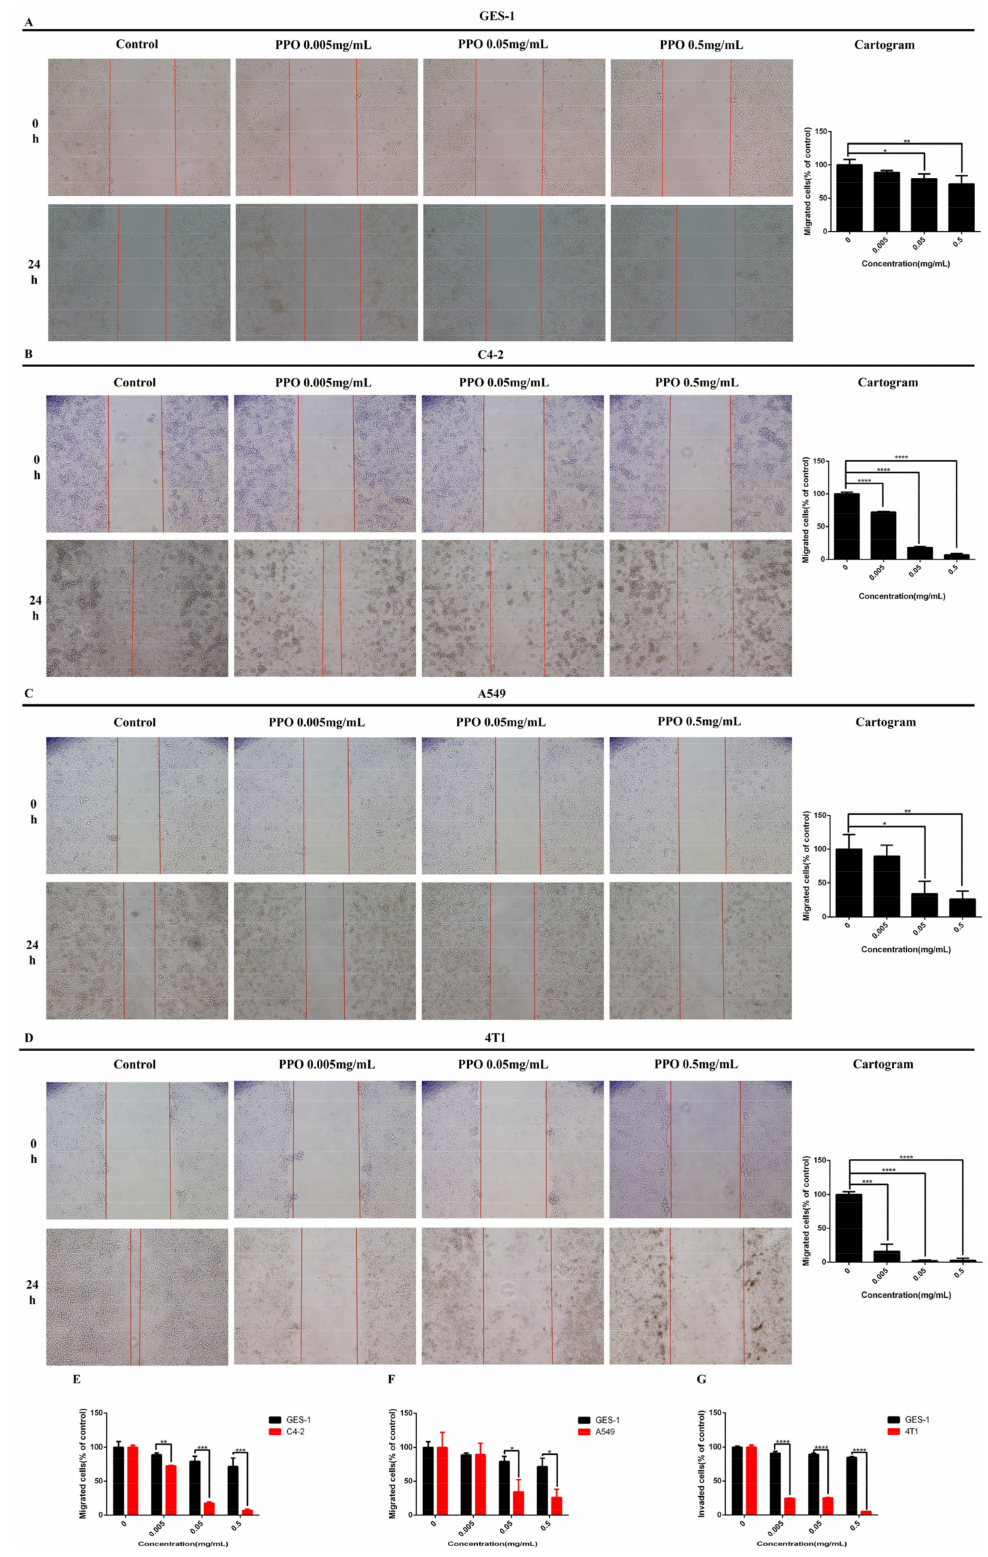
Figure 3. Effect of PPO on the migration of ( A ) human gastric normal cell GES-1, ( B ) prostate cancer cell C4-2, ( C ) lung cancer cell A549, ( D ) breast cancer cell 4T1. Comparison of the effects of PPO on the migration of ( E ) prostate cancer cell C-2, ( F ) lung cancer cell A549, ( G ) breast cancer cell 4T1 and human gastric normal cell GES-1; bars, SE (* p < 0.05; ** p < 0.01; *** p < 0.001; **** p < 0.0001 versus